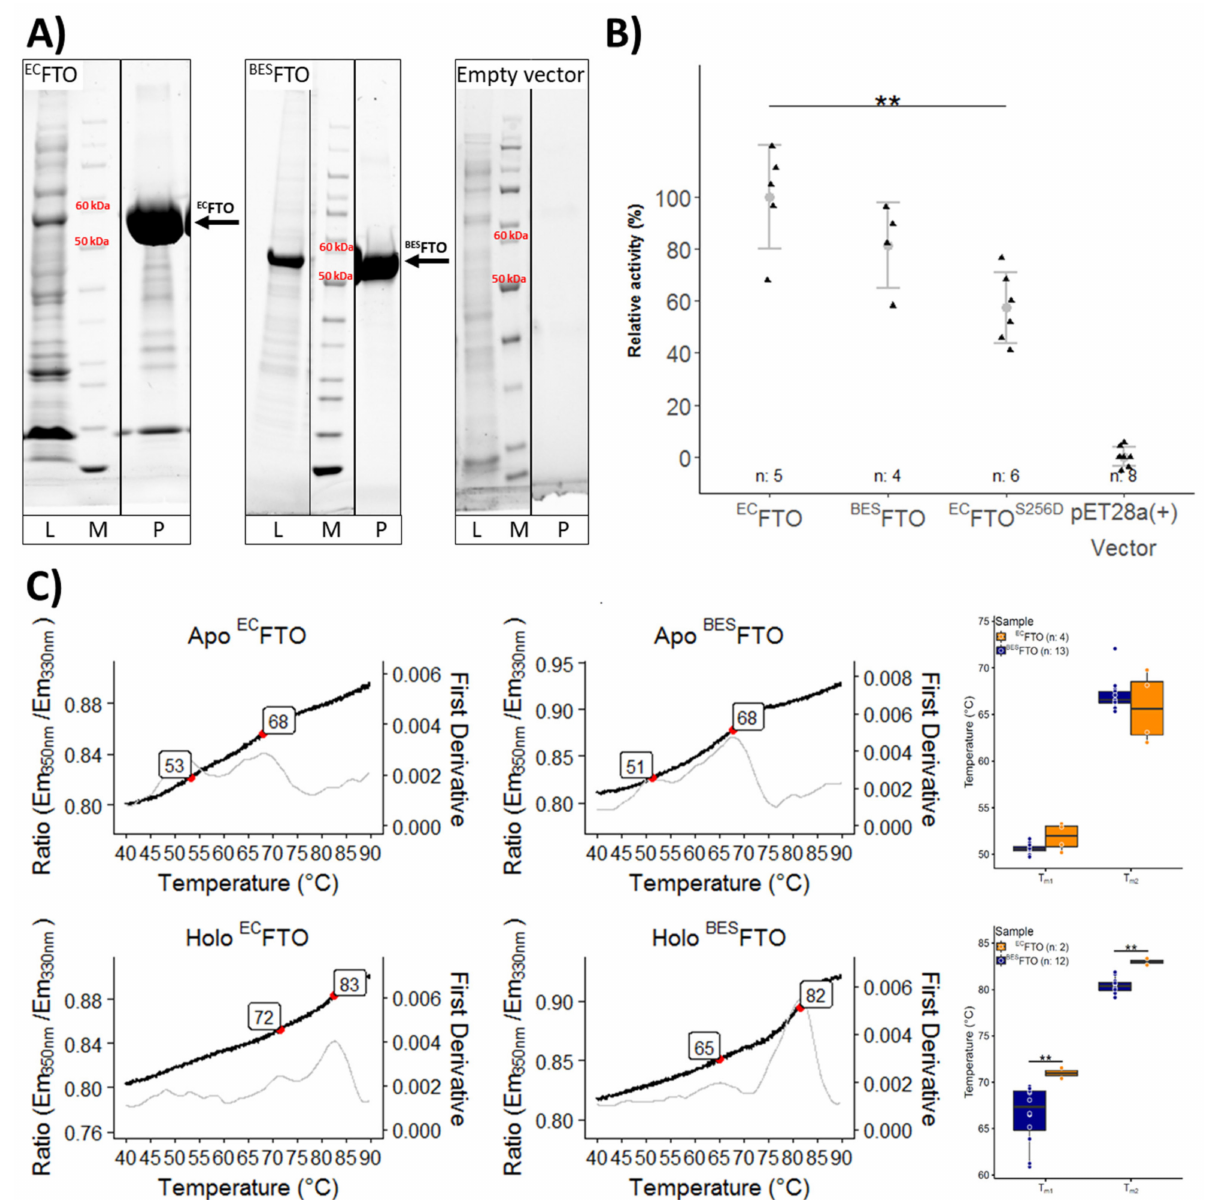
Figure 2. Purification and characterization of FTO proteins. ( A ) SDS-PAGE analysis of EC FTO and BSE FTO purification. E. coli BL21 carrying empty pET-28a(+) plasmid is a negative control. L—7.5 µ L of cell lysate, M—molecular marker, P—purified EC FTO (42 µ g), BES FTO (17 µ g), or negative control. ( B ) Enzymatic activity of EC FTO, BES FTO and EC FTO S256D mutant based on chemiluminescence assay. N 6 -meA was used as a substrate. Relative activity is referenced to activity of 1 µ g of EC FTO (100%). Data are represented as points and means with whiskers showing standard deviation. n—number of samples. ** p < 0.05. ( C ) NanoDSF analysis of the thermal stability of purified EC FTO and BES FTO in the absence (apo) or presence of Mn 2+ and 2-OG (holo). Left and middle, ratio of emissions (bold lines) and first derivative (thin lines) curves as a function of temperature. All four protein samples display two unfolding transitions (red dots): one (T m1 ) less prominent, at a lower temperature, and the second (T m2 ) clearer at a higher temperature. Right, gathered data represented as boxplots. The box represents the interquartile range. Whiskers show the highest and the lowest data points. The horizontal line within a box represents the median value. n—number of samples. ** p <